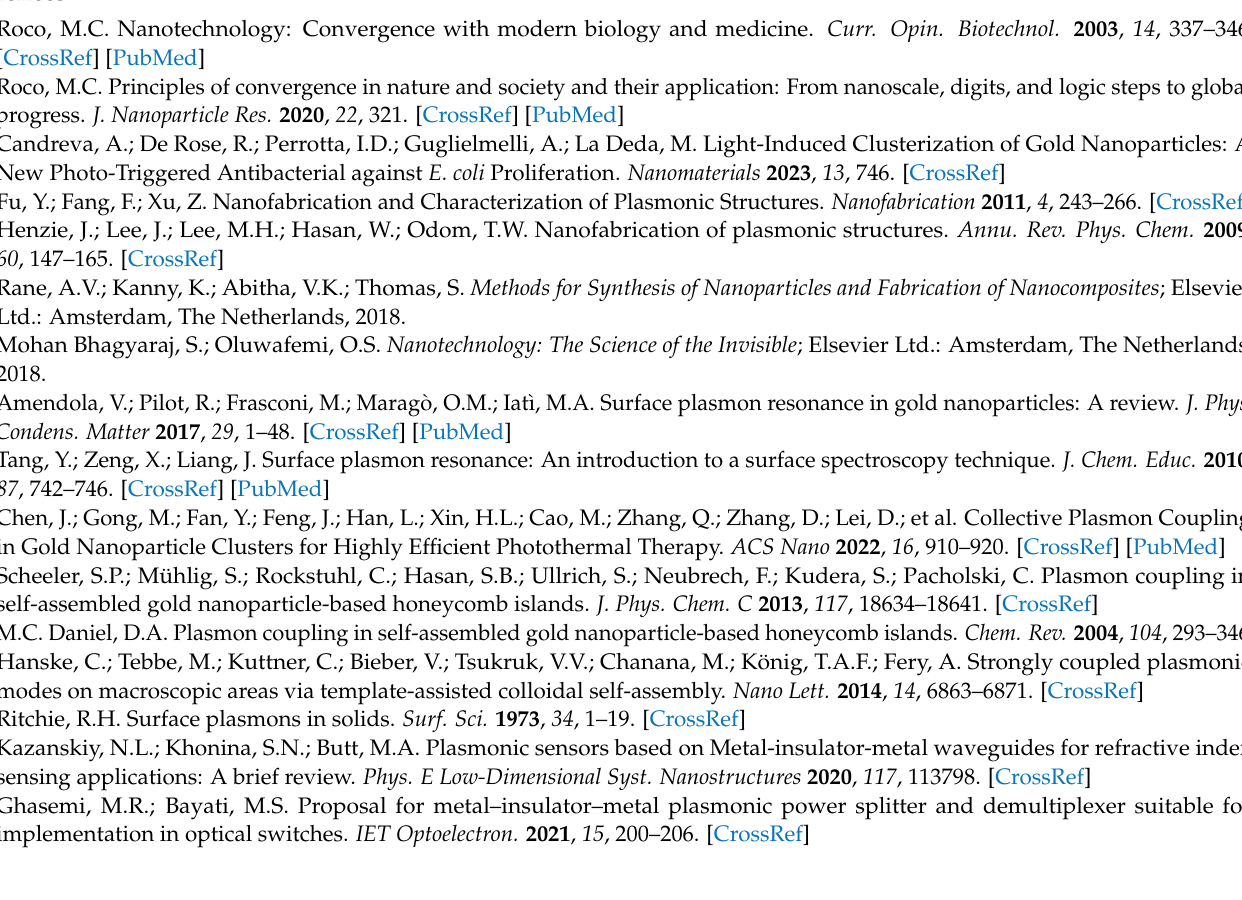
Figure S3: EDX measurement of AuNR@SiO 2 @Au@SiO 2 ; Table S1: Parameters used in the numerical modelling of the